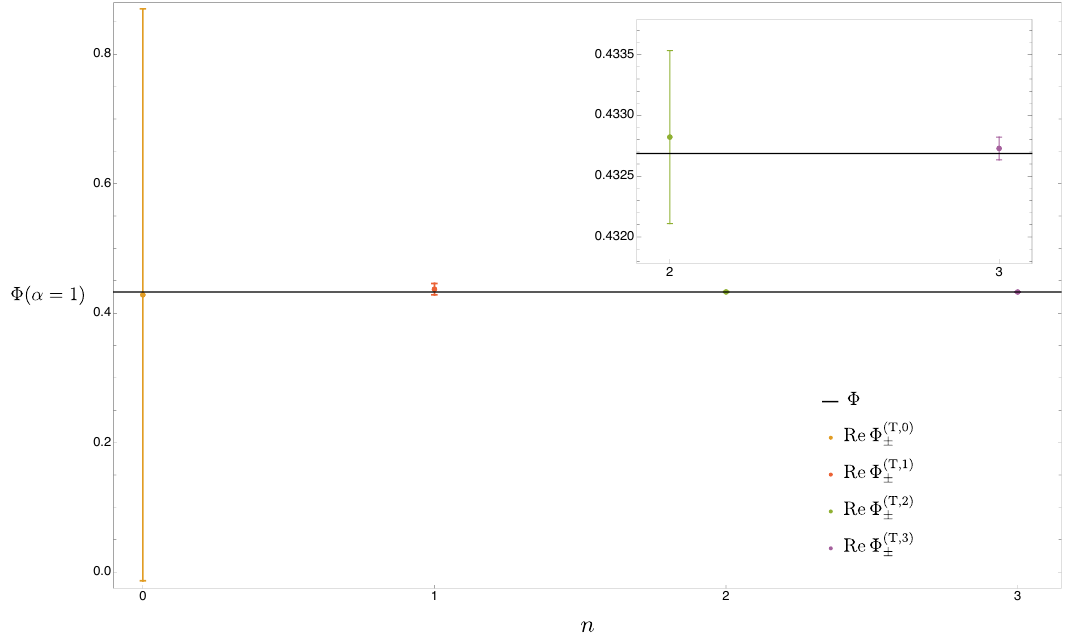
Figure 3 . The real part of the resummed truncated trans-series Φ (T ,n ) defined as in (5.51) as a function of n . The black horizontal line is the exact value. The box to the top-right is a zoom of the last two points and their error bars. The error bars are given by the left-over ambiguity in the truncated